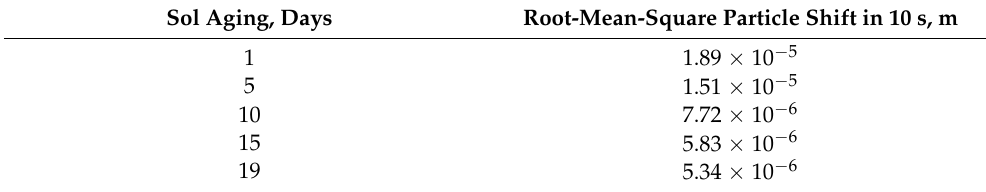
Table 5. RMS particle shift for sols of different ages.